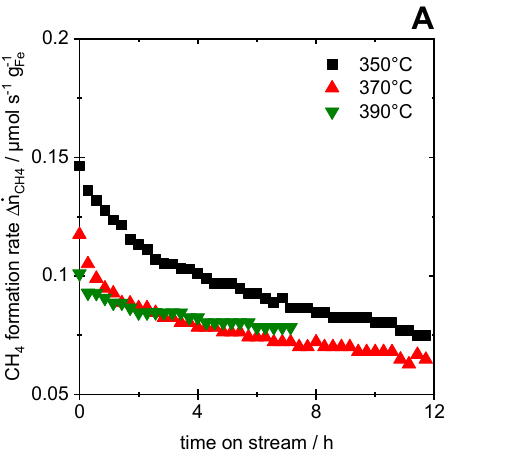
. n i as function of time-on-stream for CH 4 ( A ) and CO ( B ) during CO 2 Figure 6. Formation rates ∆ Figure 6. Formation rates ∆(cid:1866)(cid:4662) (cid:3036) as function of time-on-stream for CH 4 ( A ) and CO ( B ) during CO 2 hydrogenation at 350, 370 and 390 ◦ C with Fe@SiO 2 catalyst; conditions: H 2 /CO = 4.5, 200 mg of hydrogenation at 350, 370 and 390 °C with Fe@SiO 2 catalyst; conditions: H 2 /CO = 4.5, 200 mg of catalyst, 1 bar, total volumetric flow rate 100 ml STP catalyst, 1 bar, total volumetric flow rate 100 ml STP /min.